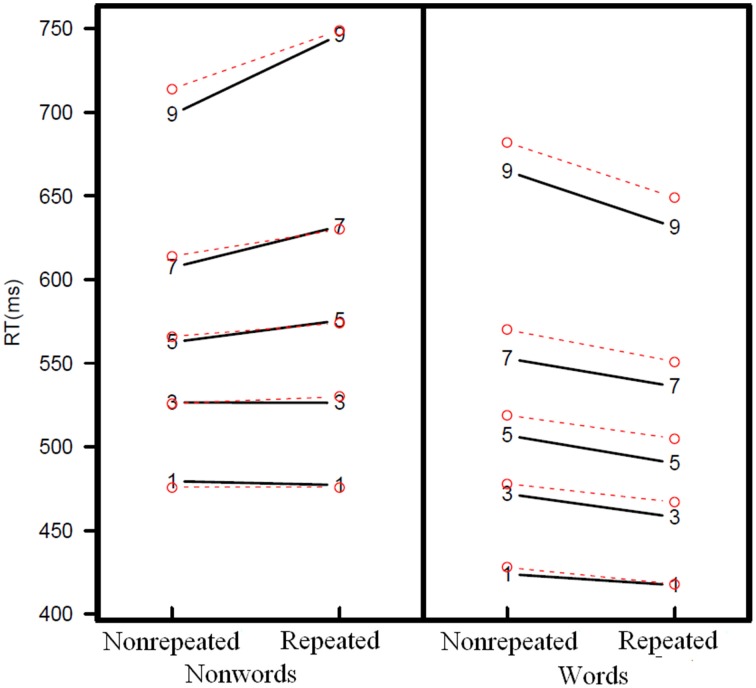
Latencies at five quantiles for the grouped data (vincentiles). The points represent (from bottom to top) the 0.1, 0.3, 0.5, 0.7, and 0.9 quantiles. The digits represent the empirical data, and the points represent the model fits.